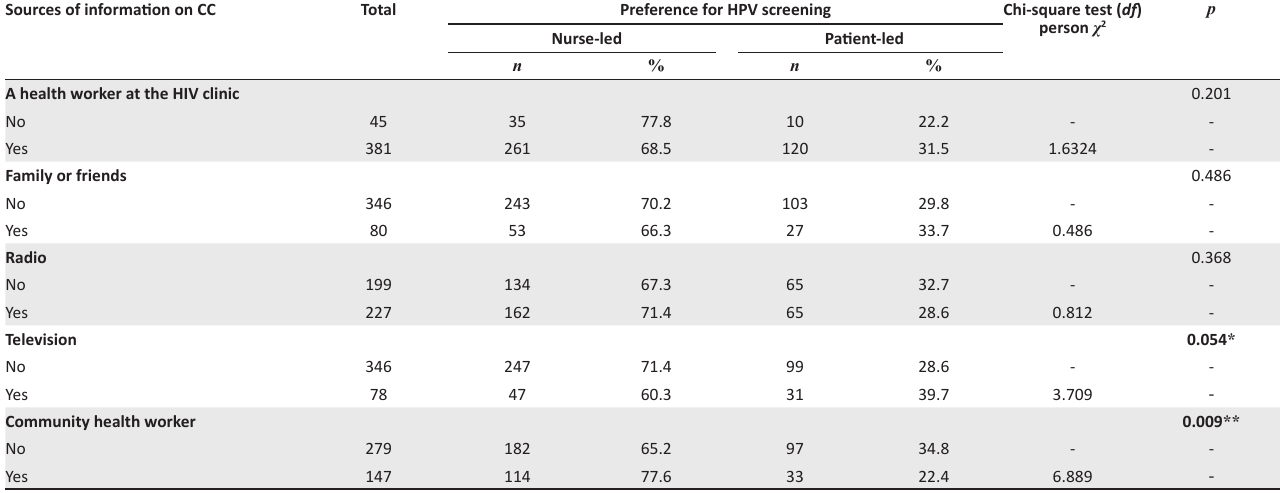
TABLE 2: Chi-square analysis of sources of information on cervical cancer associated with preference for human papilloma virus sample collection procedure among women living with HIV at a rural HIV clinic. Sources of information on CC